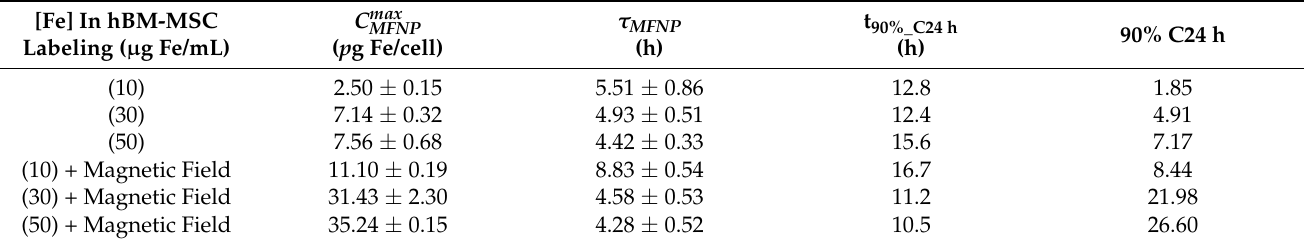
Table 4. The maximum concentrations of nanoparticles ( C max internalization ( τ MFNP ) according to Equation (1), and the recommended incubation time (t 90%_C24 h ) to reach 90% of the concentration of MFNP internalized in 24 h (90% C24